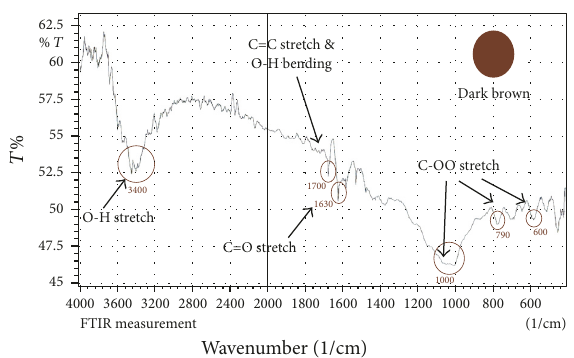
Figure 1: The FTIR transmission spectrum of GO produced by Hammers method.